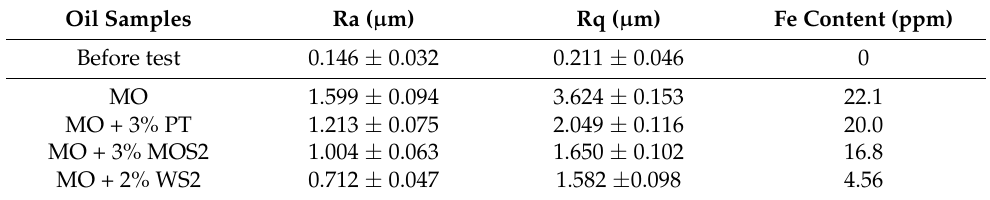
Table 2. The surface roughness of the balls and the Fe content in the oils after the anti-wear test. Oil Samples Before